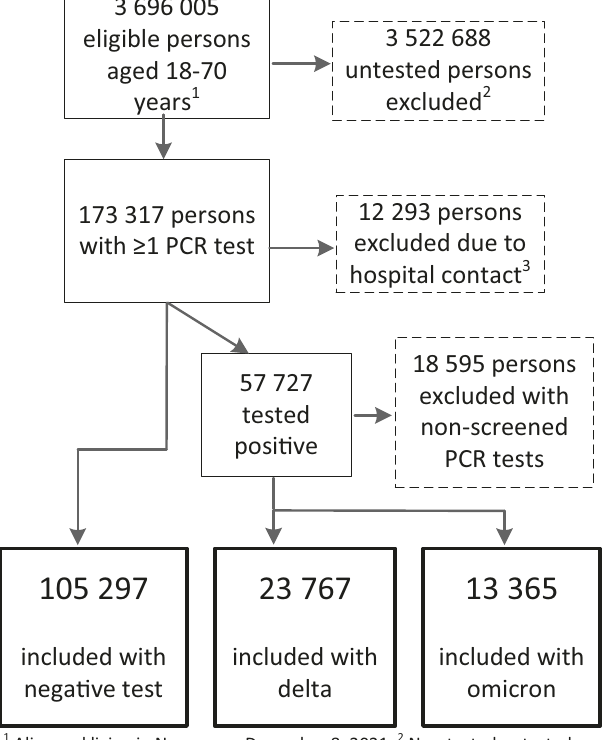
Fig.1|Flowchartpresentingeligible,excludedandincludedindividualsinthe main analyses. PCR polymerase chain reaction. Source data are provided as a Source Data fi